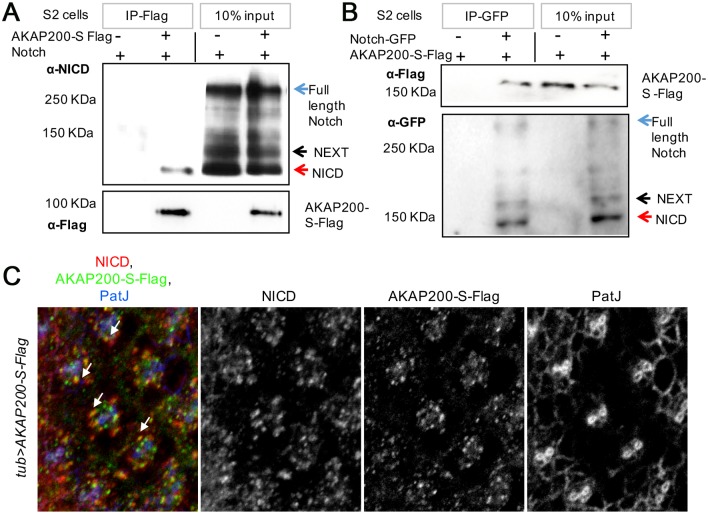
Association of AKAP200 and Notch.(A) Notch is co-immunoprecipitated by AKAP200-S: immunoblot from S2 cell whole cell lysates expressing Notch either in combination with Flag-control or AKAP200-S-Flag. Cell lysates were immunoprecipitated with anti-Flag antibody (IP-Flag) and blots were probed with anti-NICD antibody, revealing specific co-IP of Notch with AKAP200-S-Flag with no binding to Flag (right panel-10% input, bottom panel- blots probed with anti-Flag antibody). The specific interaction of AKAP200 and the NICD could be because of the experimental conditions; full length Notch is a large membrane bound protein (270 KDa) it may not be as easily accessible to AKAP200 as the NICD. Given the large size of full length Notch, one cannot exclude the possibility that the physical conformation of the interaction prevents co-immunoprecipitation; for example, AKAP200 maybe buried inside full length Notch. (B) AKAP200-S is coimmunoprecipitated by Notch: immunoblot from S2 cell whole cell lysates expressing AKAP200-S-Flag in combination with GFP-control or Notch-GFP. Cell lysates were immunoprecipitated with anti-GFP antibody (IP-GFP) and blots were probed with anti-Flag antibody, revealing specific co-IP of AKAP200-S-Flag with Notch with no binding to GFP (right panel-10% input, bottom panel- blots probed with anti-GFP antibody). (C) Confocal eye sections from third larval instar eye discs of tub>AKAP200-S-Flag depicting localization AKAP200-S, Notch, and PatJ (marking cellular outlines at junctional level and highlighting developing PR clusters, with strongest staining observed in R2/R5). Note co-localization between anti-NICD punctae and AKAP200-S-Flag (example marked by white arrow), Pearson co-efficient R = 0.67.